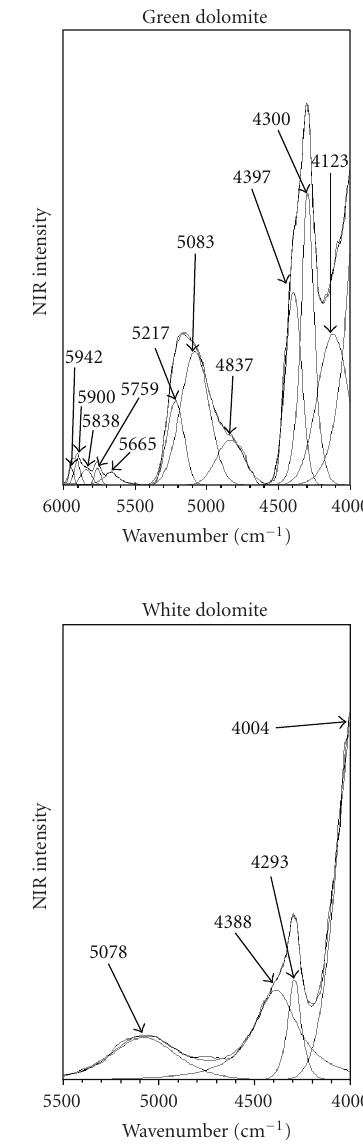
Figure 5: NIR spectrum of dolomite at room temperature from 11000–5500 cm − 1 .